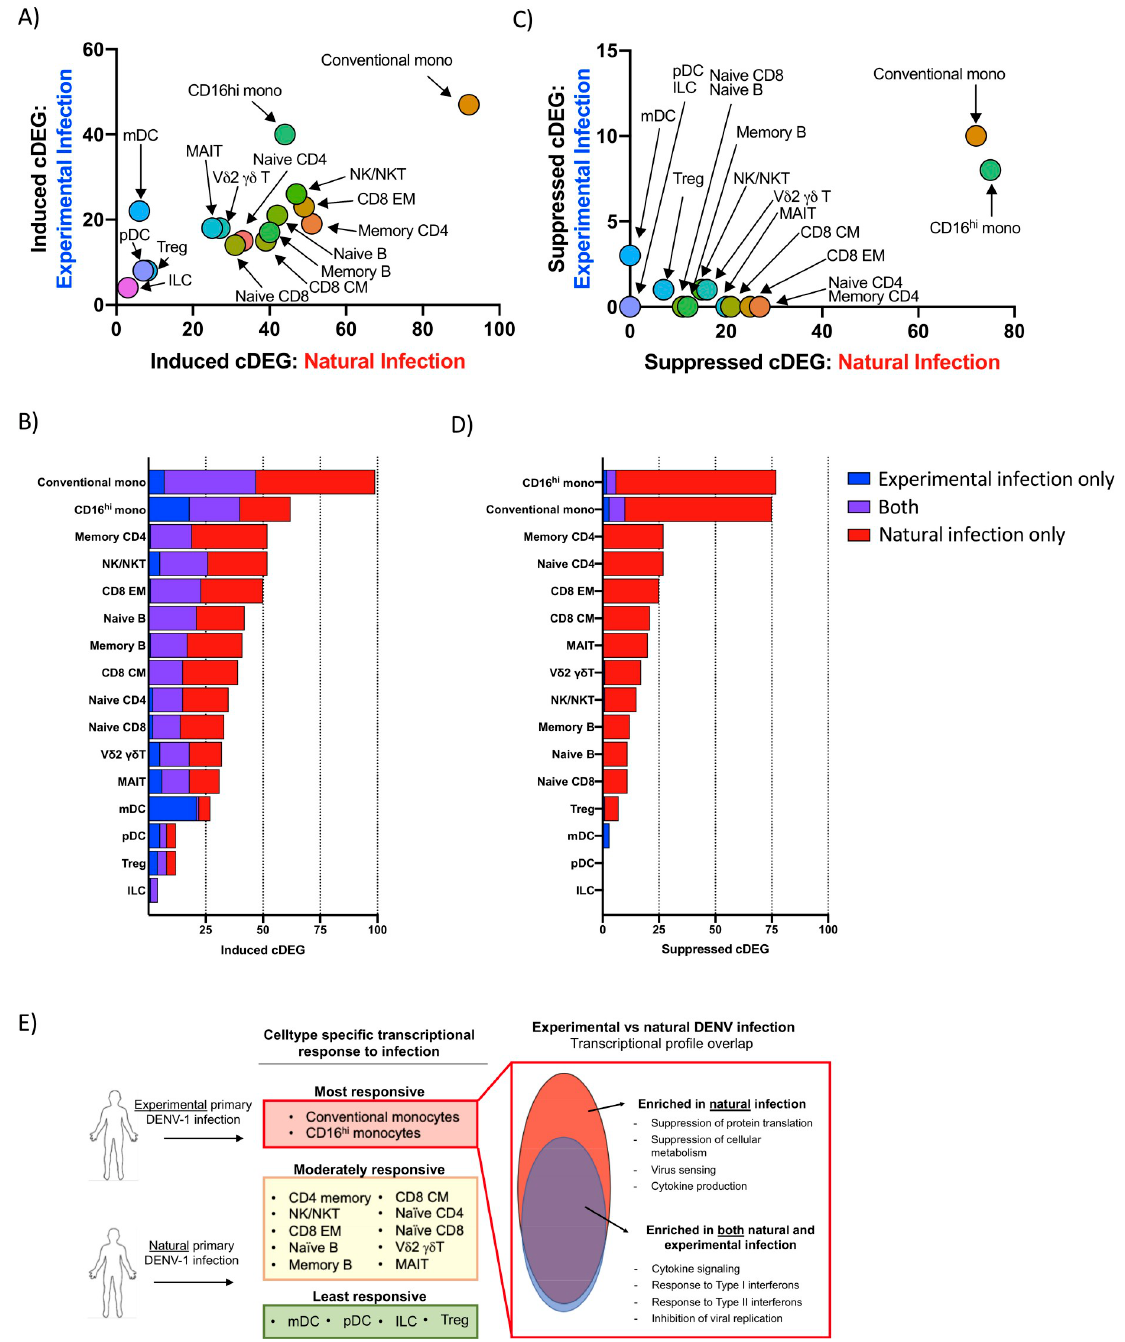
Fig 5. Transcriptional profile overlap of experimental and natural primary DENV-1 infection A) Frequency and cell-population distribution of infection-induced cDEGs identified following experimental or natural primary DENV-1 infection. Experimental primary DENV-1 infection cDEGs restricted to study day 10. B) Frequency and overlap of infection-induced cDEGs identified following experimental or natural primary DENV-1 infection C) Frequency and cell-population distribution of infection-suppressed cDEGs identified following natural primary or experimental DENV-1 infection. Experimental primary DENV-1 infection cDEGs restricted to study day 10. D) Frequency and overlap of infection-suppressed cDEGs identified following natural or experimental primary DENV-1 infection. F) Schematic representation of the differential gene expression responses observed following either natural or experimental primary DENV infection.